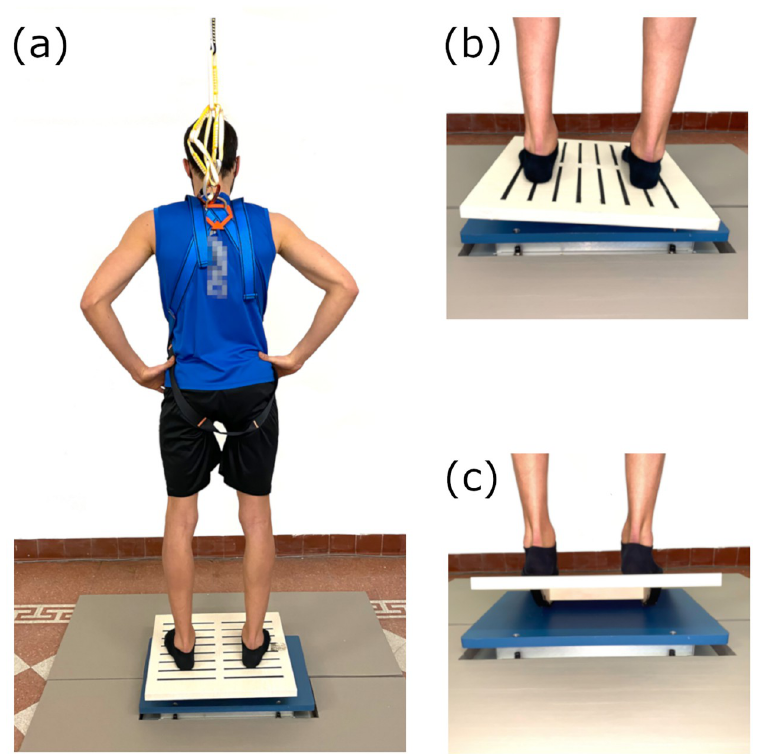
Fig 1. Experimental setup. Subject secured to a harness standing on the unstable board placed over the force platform (a); detail of the force platform and the unstable board during medio-lateral (b) and anterior-posterior (c) dynamic